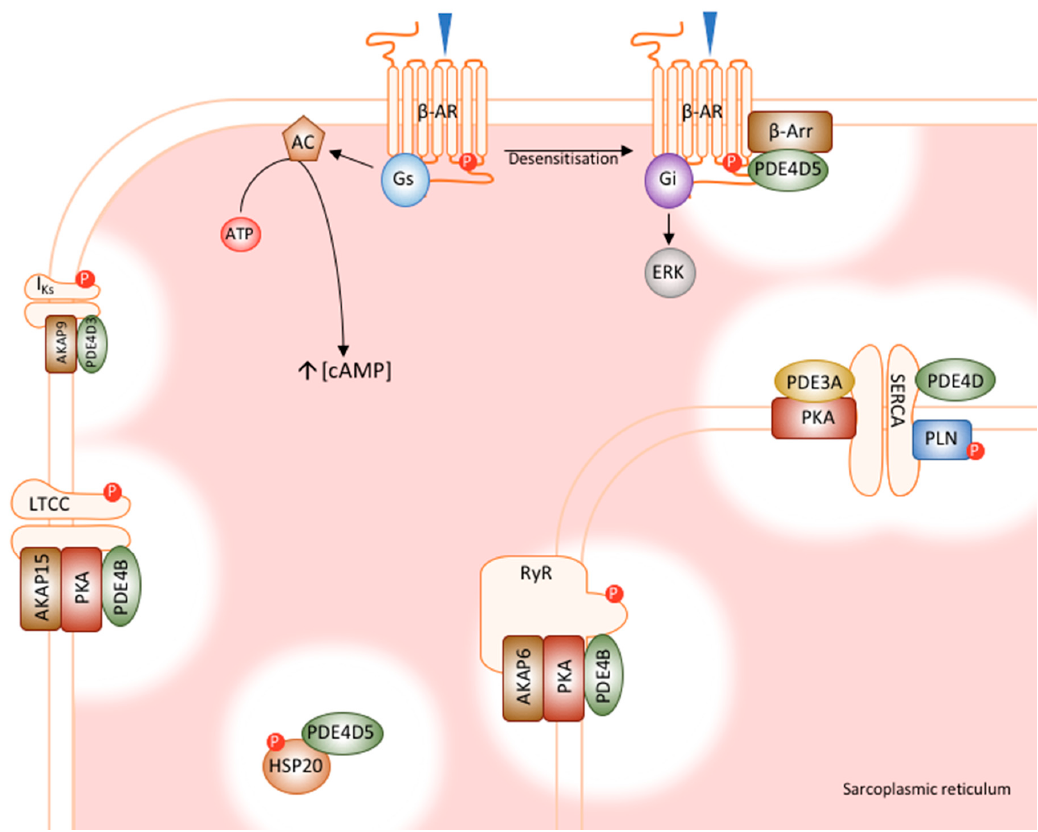
Figure 2. Cardiac PDE signalosomes. PDE4 family members have been shown to integrate into macromolecular complexes with numerous cardiac proteins, many of which are involved in excitation-contraction coupling and calcium handling. PDE4D5 interacts with β -arrestin, regulating receptor desensitisation. PDE4B regulates both the LTCC and RyR, which controls the process of calcium induced calcium release. PDE4D interacts with SERCA, regulating the reuptake of calcium into the SR. PDE4D3 interacts with IKs, modulating basal channel function. Finally, PKE4D5 regulates the cardioprotective effects of HSP20. AC, adenylyl cyclase; AKAP, A-kinase anchoring protein; ATP, adenosine triphosphate; β -AR, β -adrenoceptor; β -Arr, β -arrestin; ERK, extracellular signal regulated kinases; G i ; inhibitory G-protein; G s , stimulatory G-protein; HSP20, heat shock protein 20; I KS , cardiac I KS potassium channel; LTCC, L-type calcium channel; P, phosphorylation; PKA, protein kinase A PLN, phosphopamban, RyR, ryanodine receptor SERCA, sarcoplasmic reticulum calcium ATPase